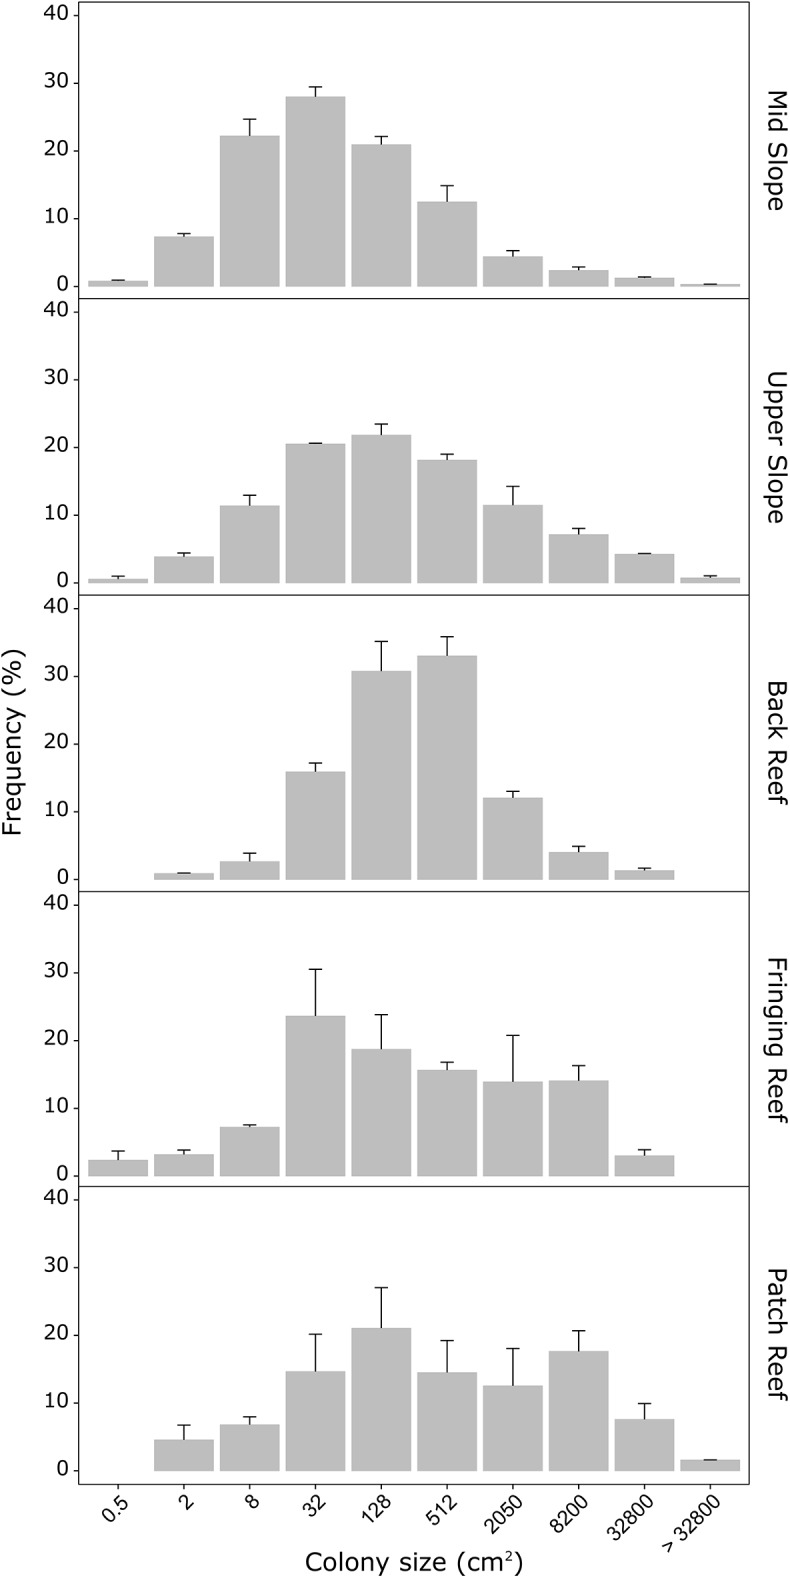
Size-frequency distributions of Millepora platyphylla across the five surveyed habitats.Colony size (cm2) data were distributed among 10 size classes based on a logarithm scale (log2). Frequencies (%) for each size class were averaged by habitats with total population size (N in S2 Table) and error bars show the standard error for transect replicates.